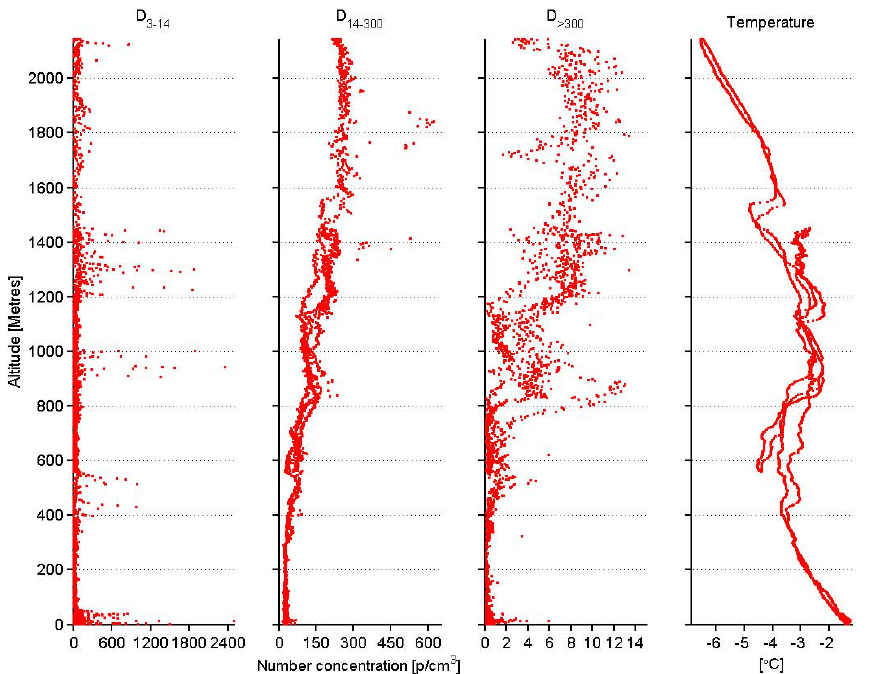
Fig. 12. Vertical profile of aerosol particle number concentration and temperature during ASCOS 2008 expedition helicopter flight, 07:57– 08:41UTC, 20 August (DoY 233)